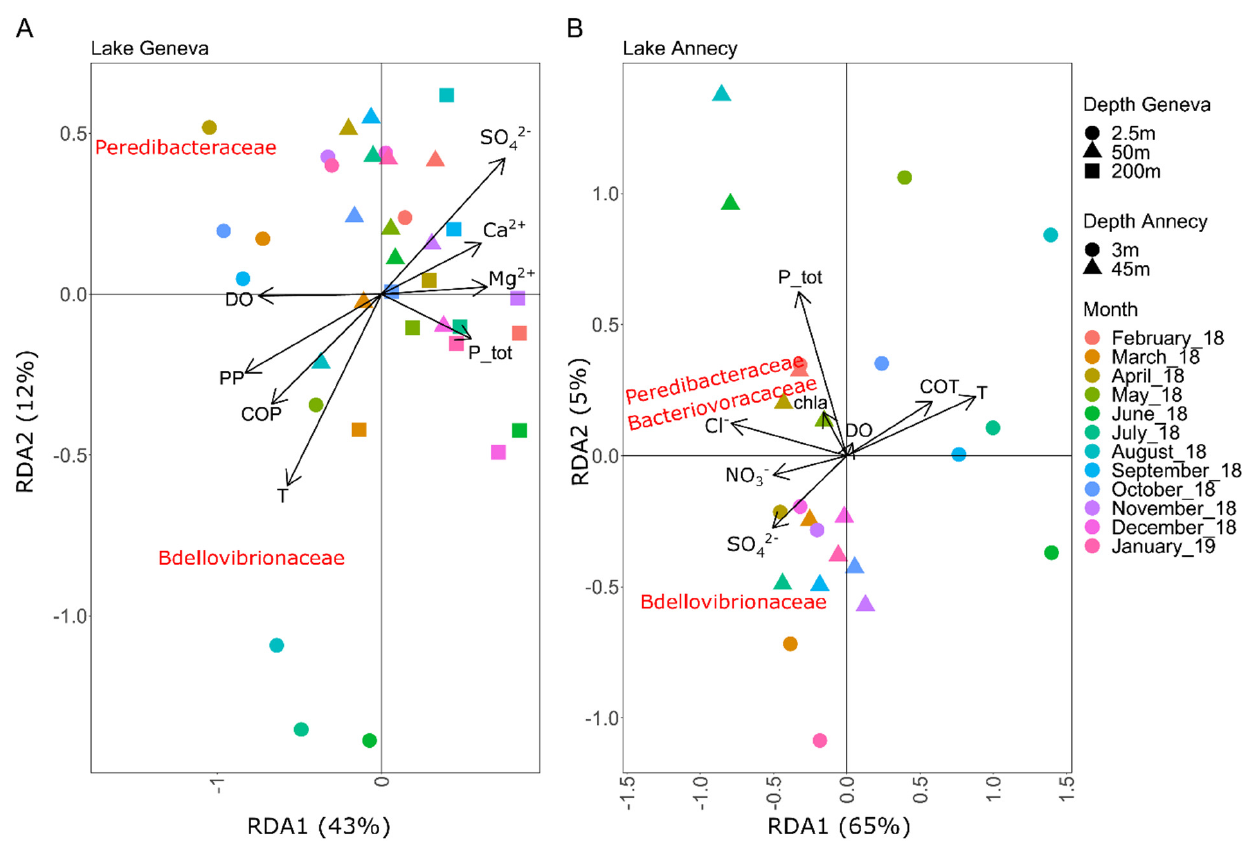
Figure 3. RDA triplots showing the relationship between BALOs abundance and significant environmental variables (VIF < 10) in Lakes Geneva and Annecy. In Lake Geneva ( A ), the first and second axis explained 43 and 12% of the variability, respectively (Anova p -value = 0.001). In Lake Annecy ( B ), the first and second axis explained 65 and 5% of the variability, respectively (Anova p -value = 0.001). Arrows indicate the direction and magnitude of variables. Ca 2+ : Calcium ion; chla: Chlorophyll a; Cl − : chloride; DO: Dissolved Oxygen; COP: Particulate Organic Carbon; COT: Total Organic Carbon; Mg 2+ : Magnesium ion; NO 3 − : Nitrate; PP: Particulate Phosphorus; P_tot: Total Phosphorus; SO 42 − : Sulfate ion; TAC: Water Hardness; T: Temperature.